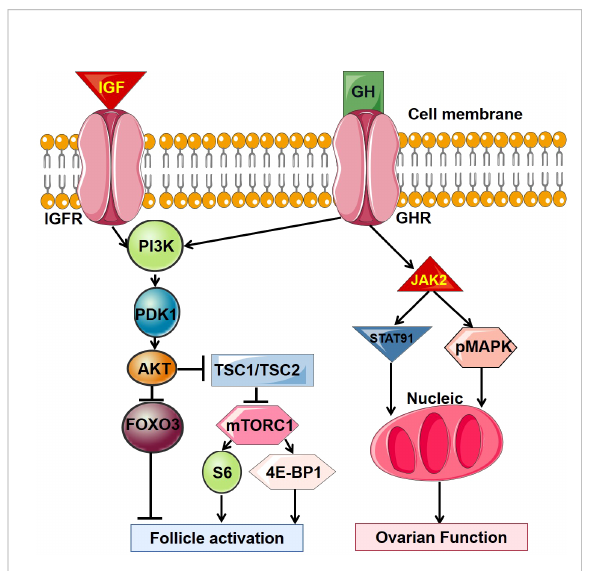
FIGURE 1 The main intracellular signal transduction pathway of GH. GH, growth hormone; GHR, growth hormone receptor; IGF, insulin- like growth factor; IGFR, insulin-like growth factor